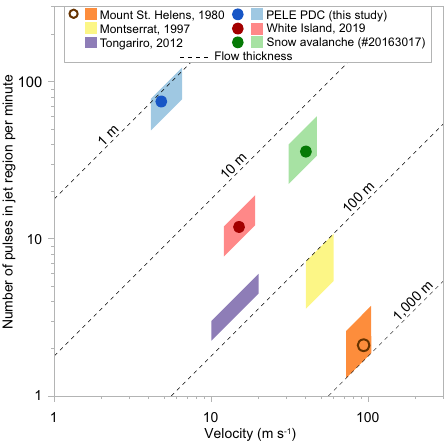
Fig. 9 Occurrence and prediction of pressure pulses in real-world fl ows. The number of dynamic pressure pulses associated with the passage of the largest-scale coherent turbulence structures in natural pyroclastic density currents, large-scale experiments, and snow avalanche #20163017. Measured data for large-scale PELE experiments, Whakaari (White Island) surges and the snow avalanche are shown as closed circles. Measured data in numerical simulation of Mount St. Helens blast is shown as open circle. Modelled numbers of pressure pulses (Eq. 10) are shown as polygons based on published data of fl ow velocity and fl ow height from the 1980 blast of Mount St. Helens (United States) 52,66 , the 1997 Boxing day blast on Montserrat (West Indies) 67 , and the 2012 blast-like surges from Tongariro (New Zealand) 68 and snow avalanche #20163017 in Vallée de la Sionne (Switzerland) 55 . The dashed lines indicate fl ow thickness. Model input data are summarised in Supplementary Table Finally, the downstream propagation and perpetuation of the coherent turbulence structures and gravity waves demonstrate how dynamic pressure energy, and therefore hazard potential, is effectively transported in pyroclastic surges outwards from source. The largest-scale coherent turbulent structures and the internal gravity waves carry the bulk of the fl ow energy and fl ow detructiveness. This highlights that evaluation of hazard models needs to be informed by the turbulence structure of pyroclastic surges. These fi ndings are important to hazard decision-making in volcanic regions globally. The turbulent and destructive pro- cesses described here are not only relevant for pyroclastic surges but for other particle-laden gravity currents as well, including powder snow avalanches, turbidity currents and dust storms.